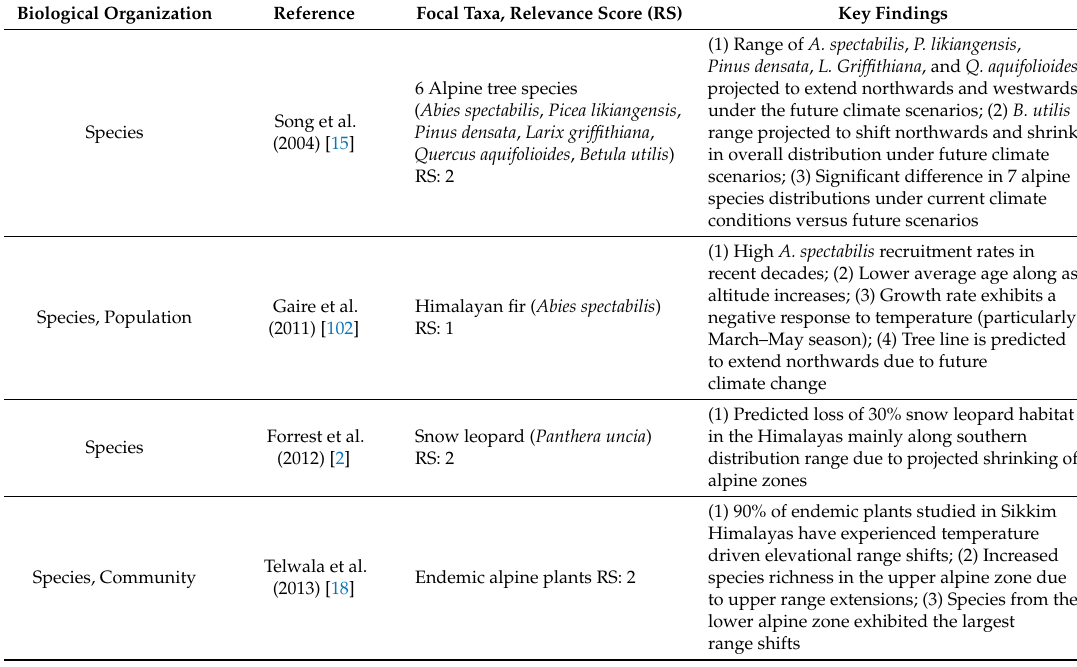
Table 3. Summary of key findings from the 13 studies used in this review, with corresponding level(s) of biological organization, reference, focal taxa and relevance score for each